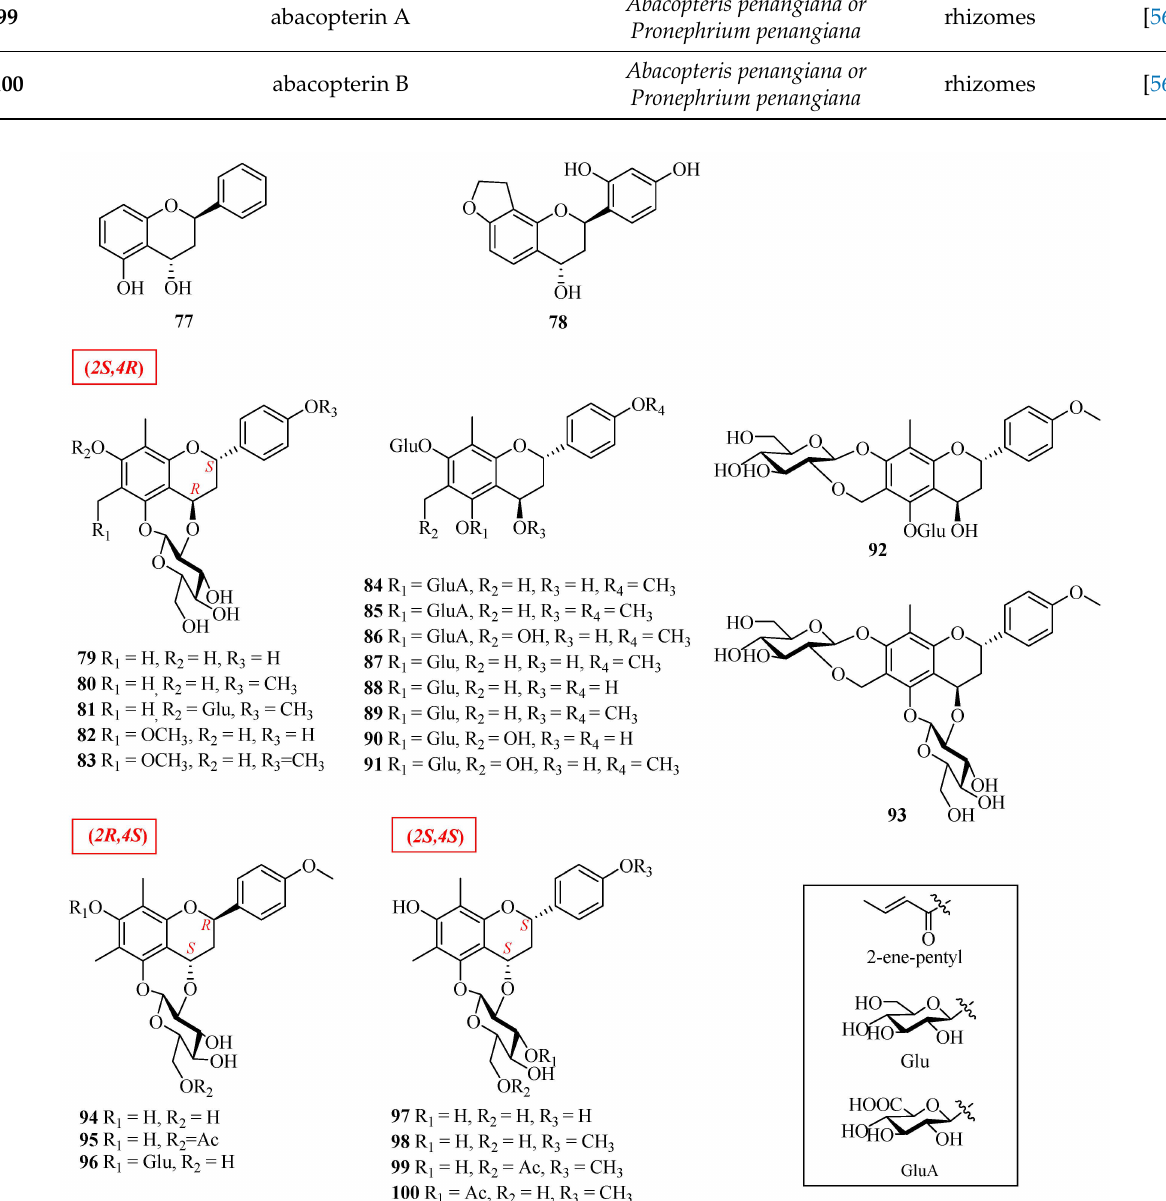
Figure 4. Structures of